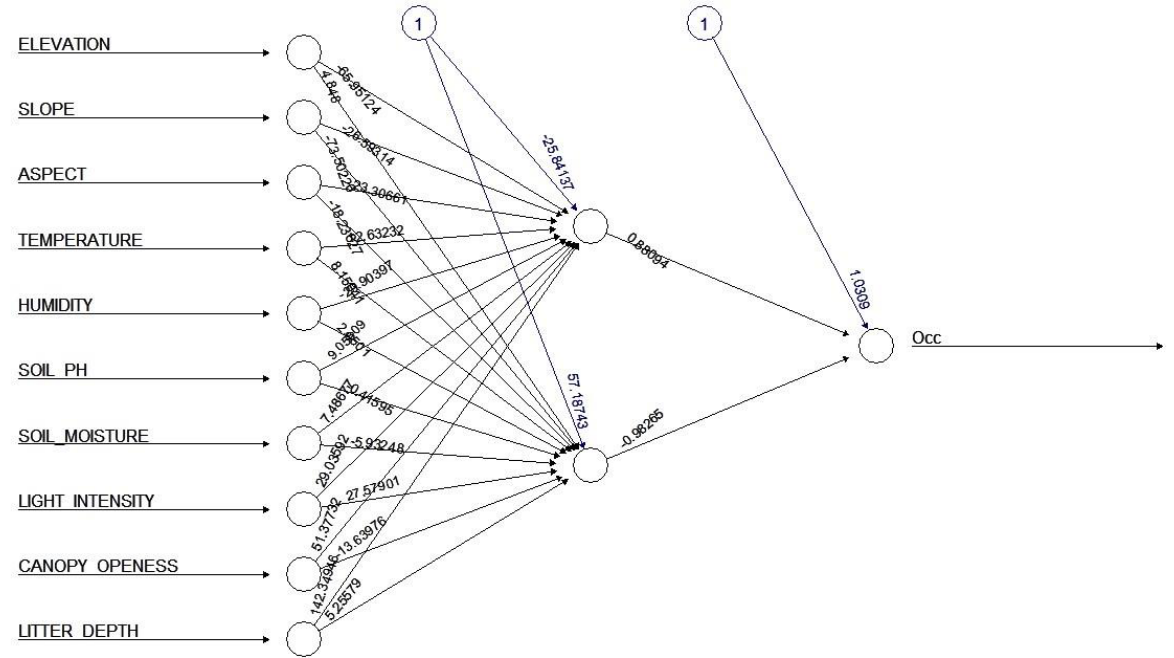
Figure 2. Artificial Neural Network (ANN) model with ten input variables, two neurons in one hidden layer, and one output.